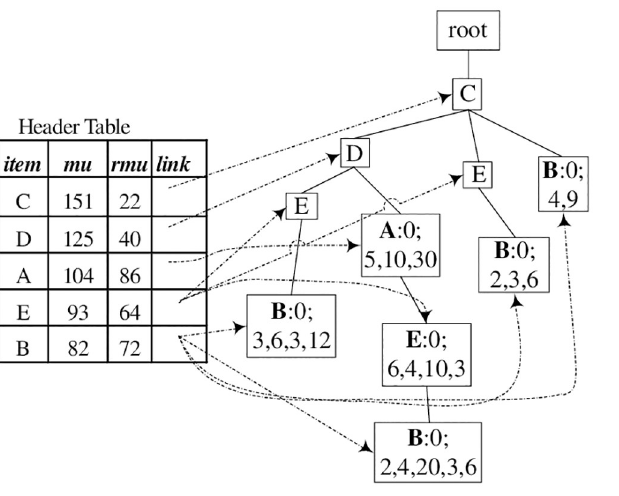
Fig 1. Example TN-tree constructed using data in Tables 1 and